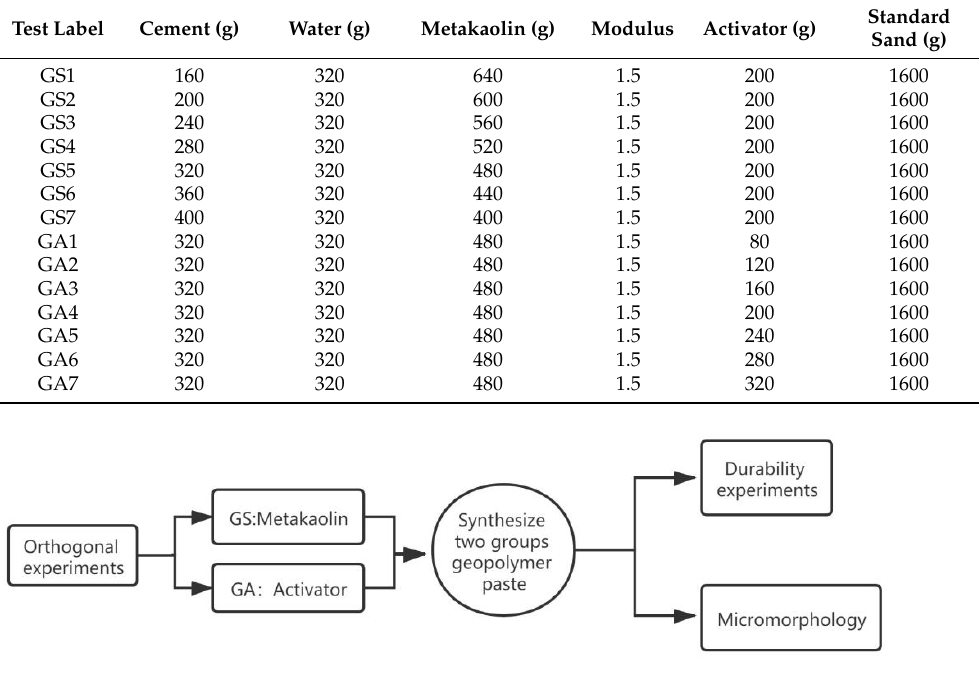
Figure 2. Geopolymeric paste durability experiments process.